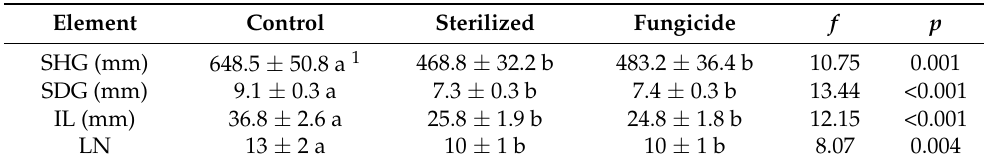
Table 3. The influence of growing Serianthes kanehirae plants in soil obtained from Serianthes nelsonii rhizosphere on growth in stem height (SHG), growth in stem diameter (SDG), maximum internode length (IL), and total leaf number (LN). Mean ± SE, n = 6.